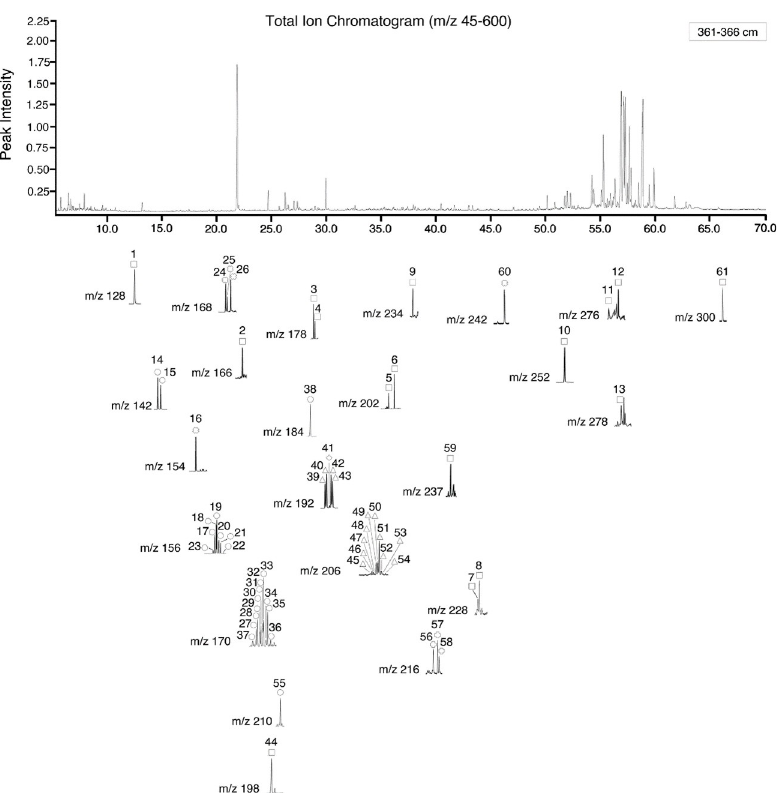
Fig 3. Total ion chromatogram (TIC) and the mass chromatograms of the molecular ions of the PAHs in sample Hole 8, 361–366 cm. The numbered spectral peaks are the compounds listed in Tables 1 and 2. https://doi.org/10.1371/journal.pone.0256853.g003 correlation with charcoal abundance (r = 0.40 and p = 0.006 for both > 125 μ m and 250 μ m charcoal fractions). In contrast, LMW PAH variation show a much lower correlation with char- coal abundance (r = 0.15 and 0.13; p = 0.30 and 0.40 for > 125 μ m and 250 μ m fractions, respec- tively). Charcoals are residues of combusted plant tissues [55]. Macroscopic charcoals with particle sizes of > 125 μ m and 250 μ m were prominent local fire tracers [56, 57]. In-situ or local fires produced more charcoal than the ex-situ or distal fire [58–60]. Previous studies have shown that larger macroscopic charcoals were formed at and near the burnt areas [57, 58, 61]. The dispersion distance of char particles ( < 200 μ m) is at a maximum of 10 km [12]. Hence, charcoal cannot be transported far. Therefore, HMW PAHs reflect the local fire, while the